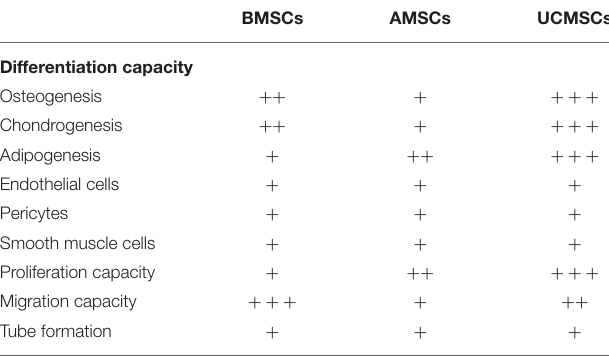
TABLE 1 | Comparison of MSCs from different